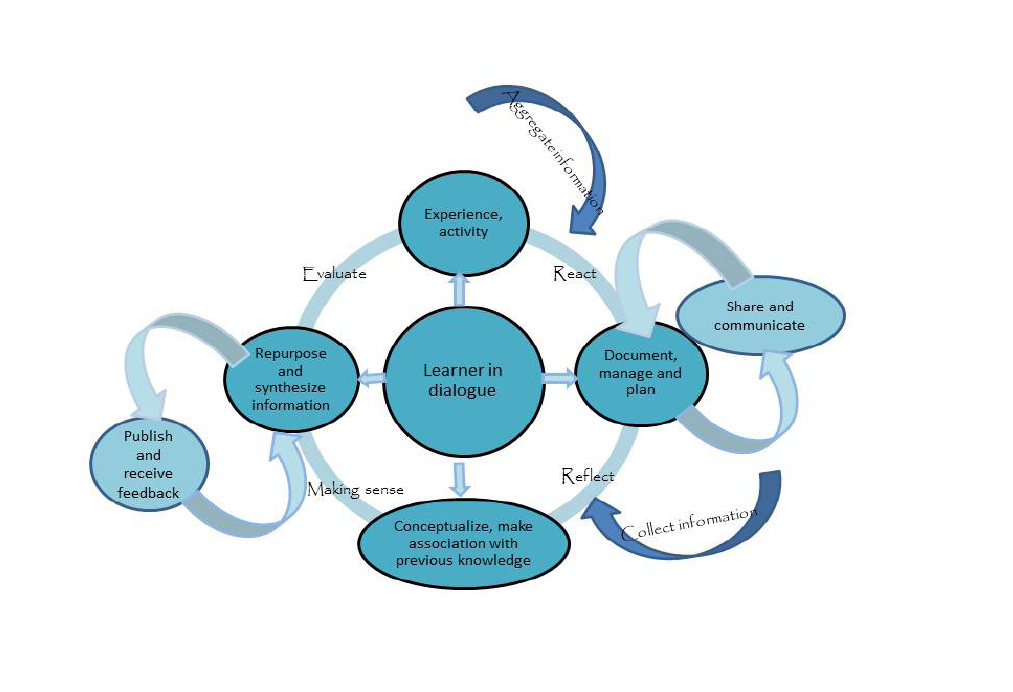
Figure 1 . Model of learning on an open networked learning environment (Kop,